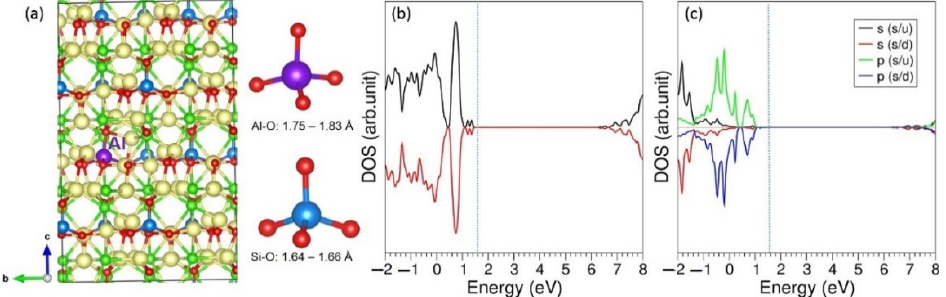
Figure 5. ( a ) Optimized structure of Al-doped Li 6 SiO 4 Cl 2, ( b ) its total DOS plot, and ( c ) atomic DOS plot of Al.